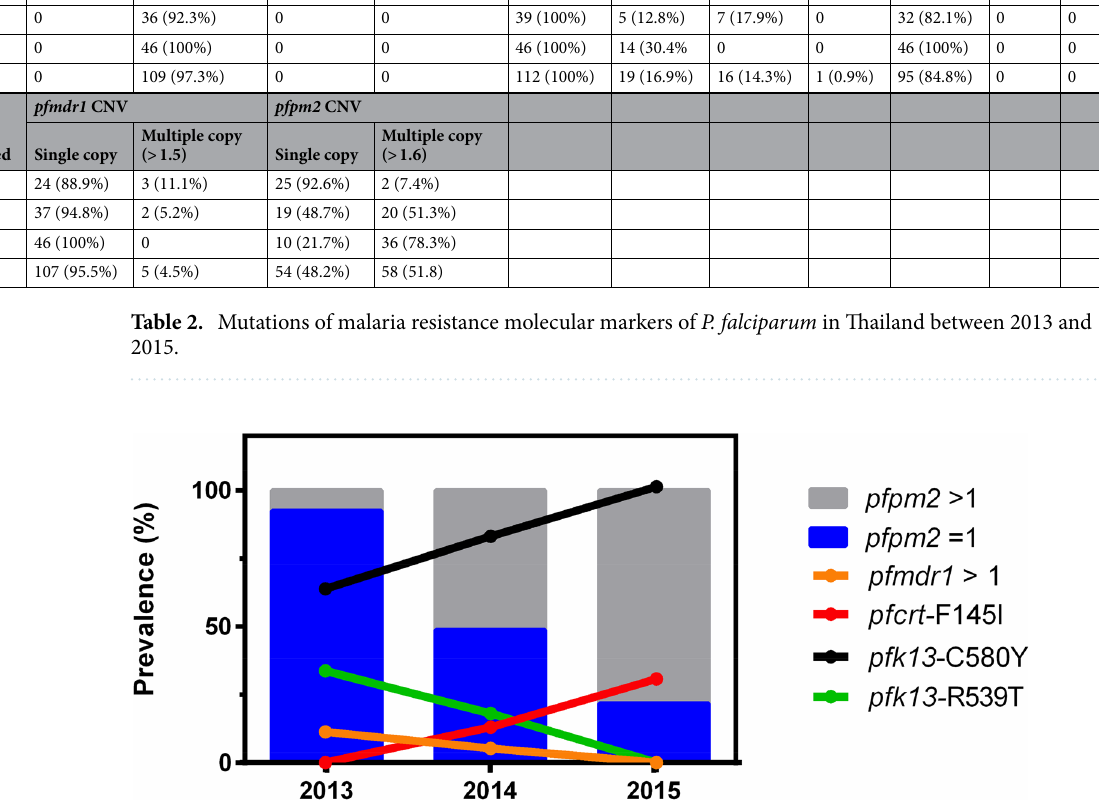
Figure 1. Prevalence of antimalarial drug resistance mutations in Thailand from 2013–2015. Bars indicate the prevalence of parasites with single and amplified pfpm2 copy number. The line graphs indicate the prevalence of parasites harboring the pfcrt- F145I mutation, amplified pfmdr1 copy number and pfk13 -C580Y and pfk13 - R539T